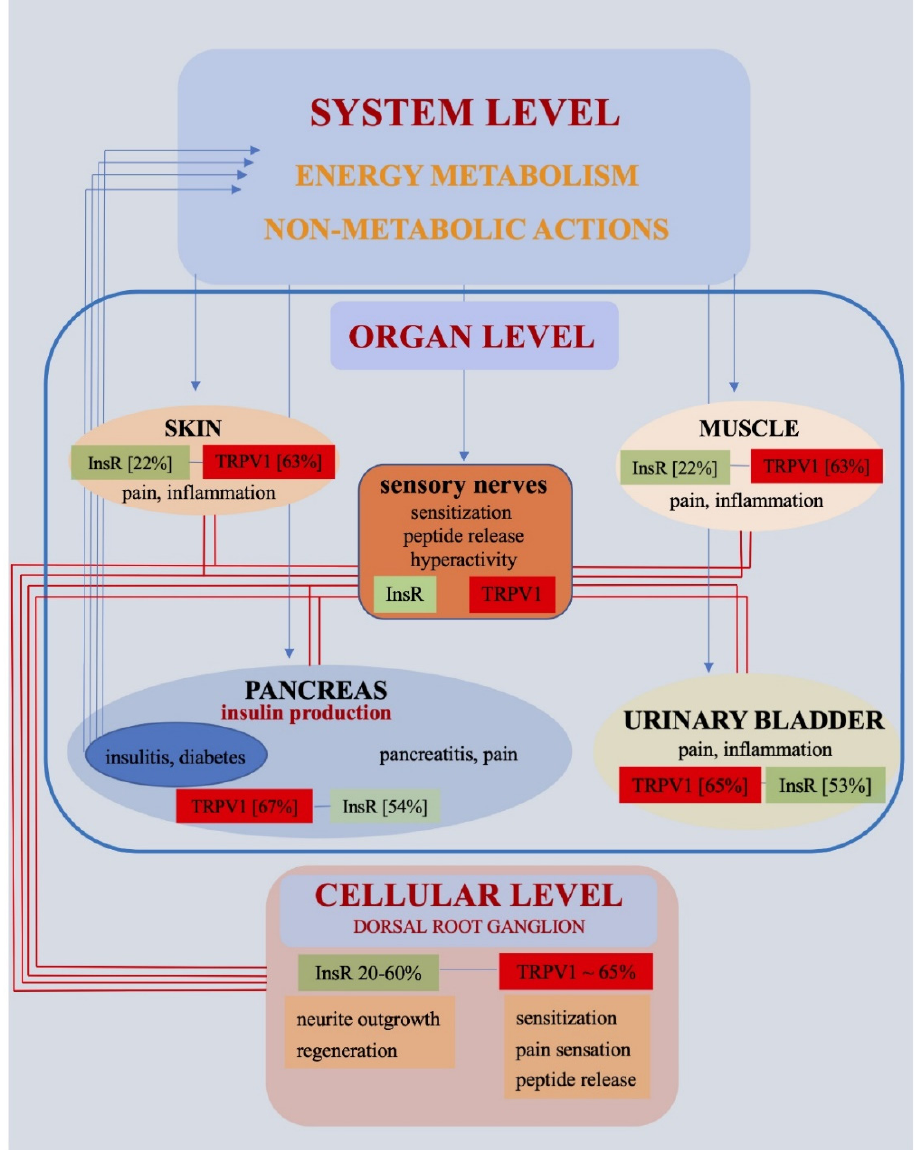
Figure 1. Insulin acts as a neuroactive substance by modulating the insulin (InsR) and transient receptor potential vanilloid type 1 (TRPV1) receptors at system, organ and cellular levels. The involvement of the InsR and the TRPV1 receptor in some physiological and pathophysiological processes is indicated. Percent values show proportions of dorsal root ganglion neurons expressing the InsR and the TRPV1 receptor innervating the